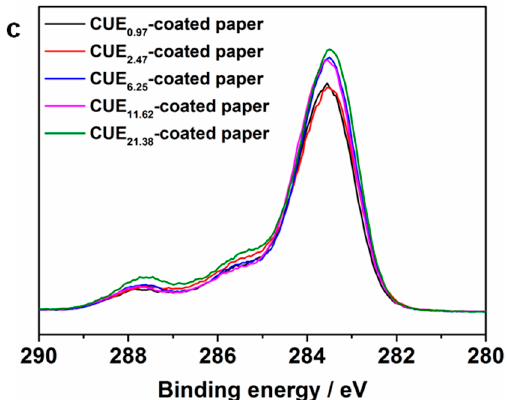
Figure 3. High-resolution C1s XPS deconvolution spectra of unmodified paper ( a ) and CUE 0.97 -coated paper ( b ); and ( c ) C1s XPS spectra of CUE 0.97 -coated paper, CUE 2.47 -coated paper, CUE 6.25 -coated paper, CUE 11.62 -coated paper and CUE 21.38 -coated paper.